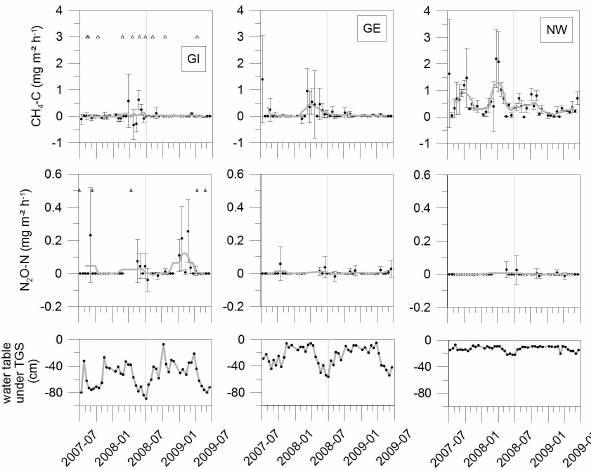
Fig. 4. CH 4 –C (top) and N 2 O–N exchange (middle) and water ta- ble (bottom) during the measuring period (from the left to the right the intensively used site GI, the extensive one GE, and the natural peat bog site NW). TGS denotes the top ground surface. Values are displayed as mean ± standard deviation of the three replicates. We had to neglect the N 2 O data between 02/28/08–05/20/08 because of problems with the gas chromatograph. The grey line symbolizes the running average of 5 values. The triangles in the left column typify (a) manuring applications for CH 4 and (b) fertilizer applications for N 2 O.